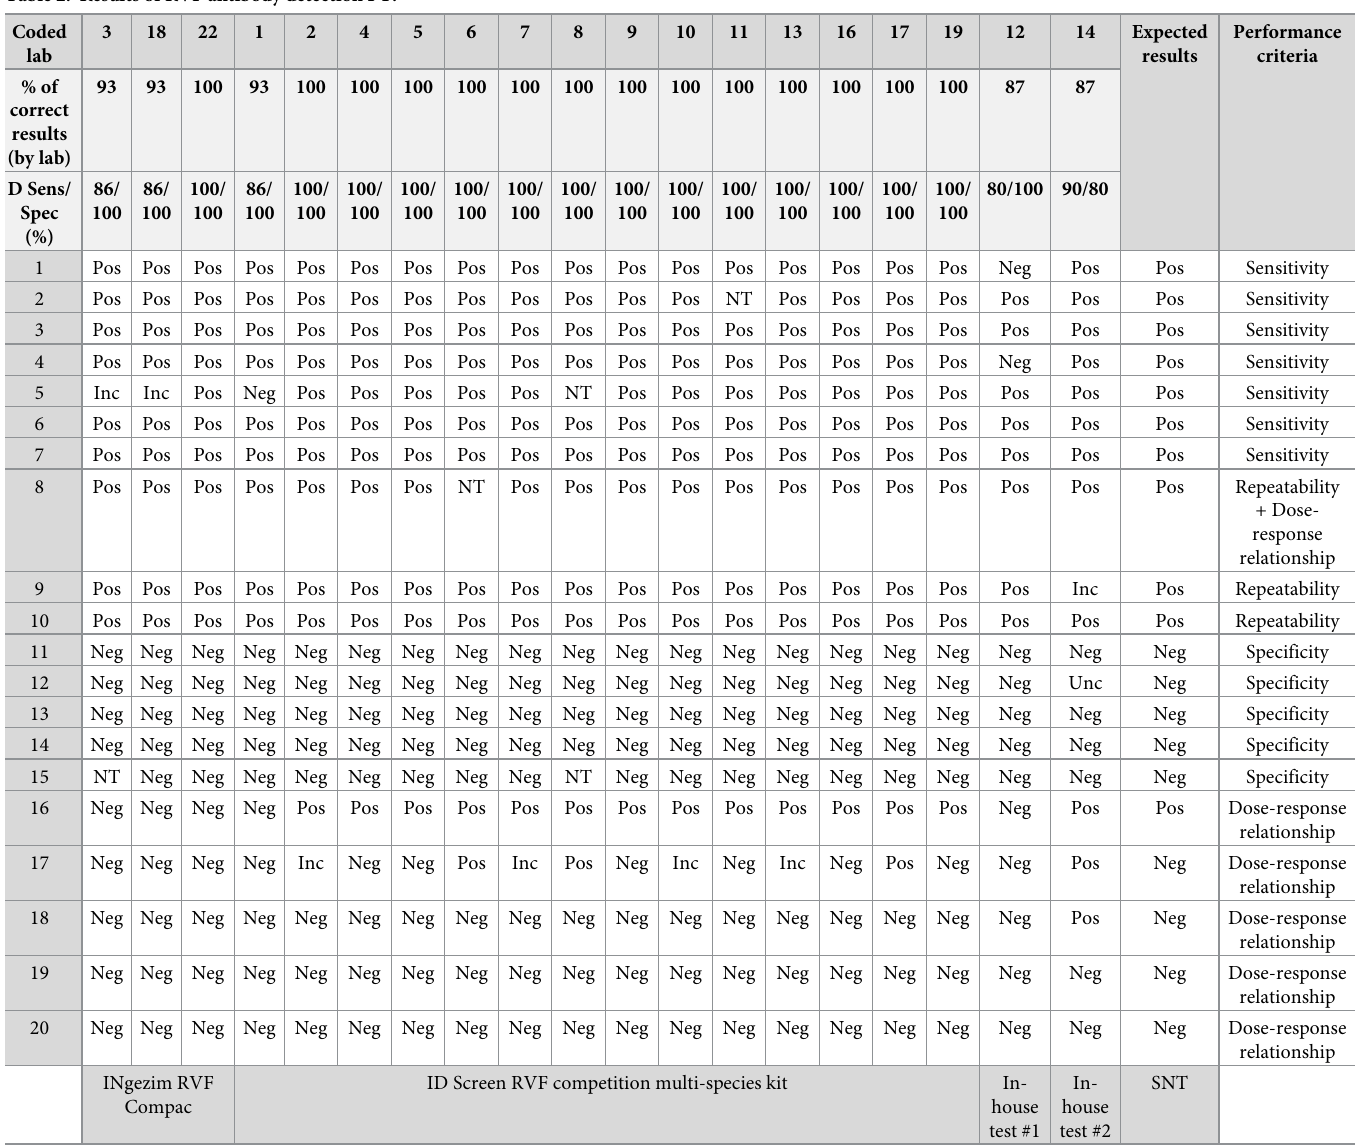
Table 2. Results of RVF antibody detection PT.